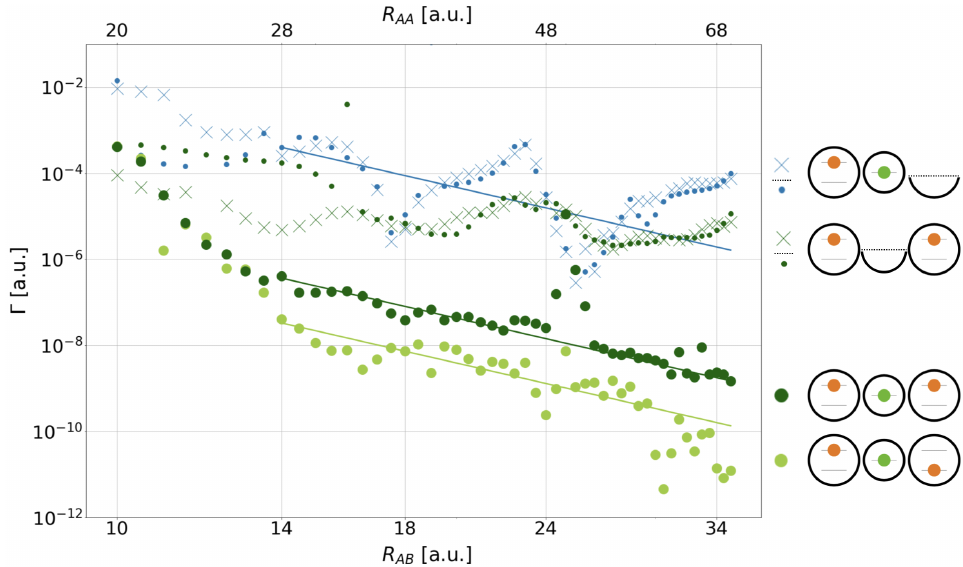
Figure 5. Double-logarithmic representation of the decay rates Γ as function of interdot distance R AB (top abscissa R AA ) for the decay processes arising from the SE and DE initial electron configuration (light and dark green large dots). The configurations are shown on the right side (bottom) also for related two-electron processes (above) in the order of their decay rates. On top, the two-QD processes (blue, dark green crosses) are shown, followed by the two-electron, three-QD processes (blue, dark green small dots); the empty/removed QD is depicted as a half circle on the right. The asymptotic regime for regular, SE-, and DE-ICD is indicated by the rates’ least-squares fit to R − 6 lines in the corresponding